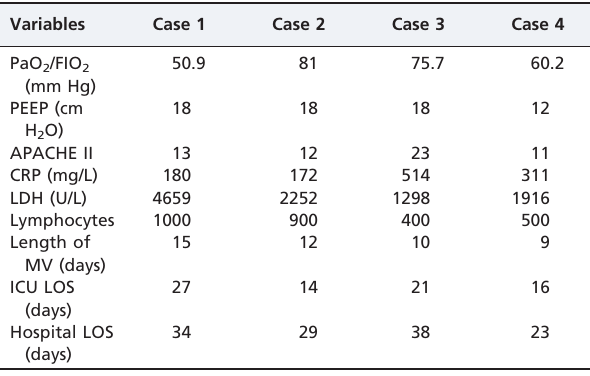
Table 1 - Intensive care unit data from patients with ARDS caused by influenza A (H1N1) virus included in this case